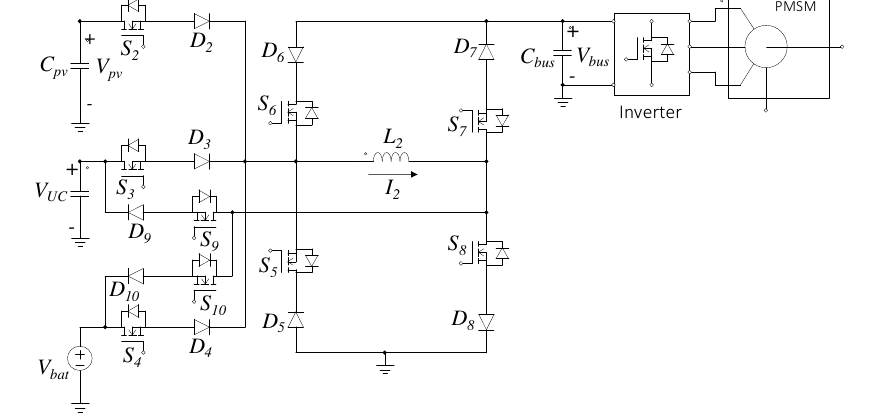
Figure 4. Multiple-input converter.